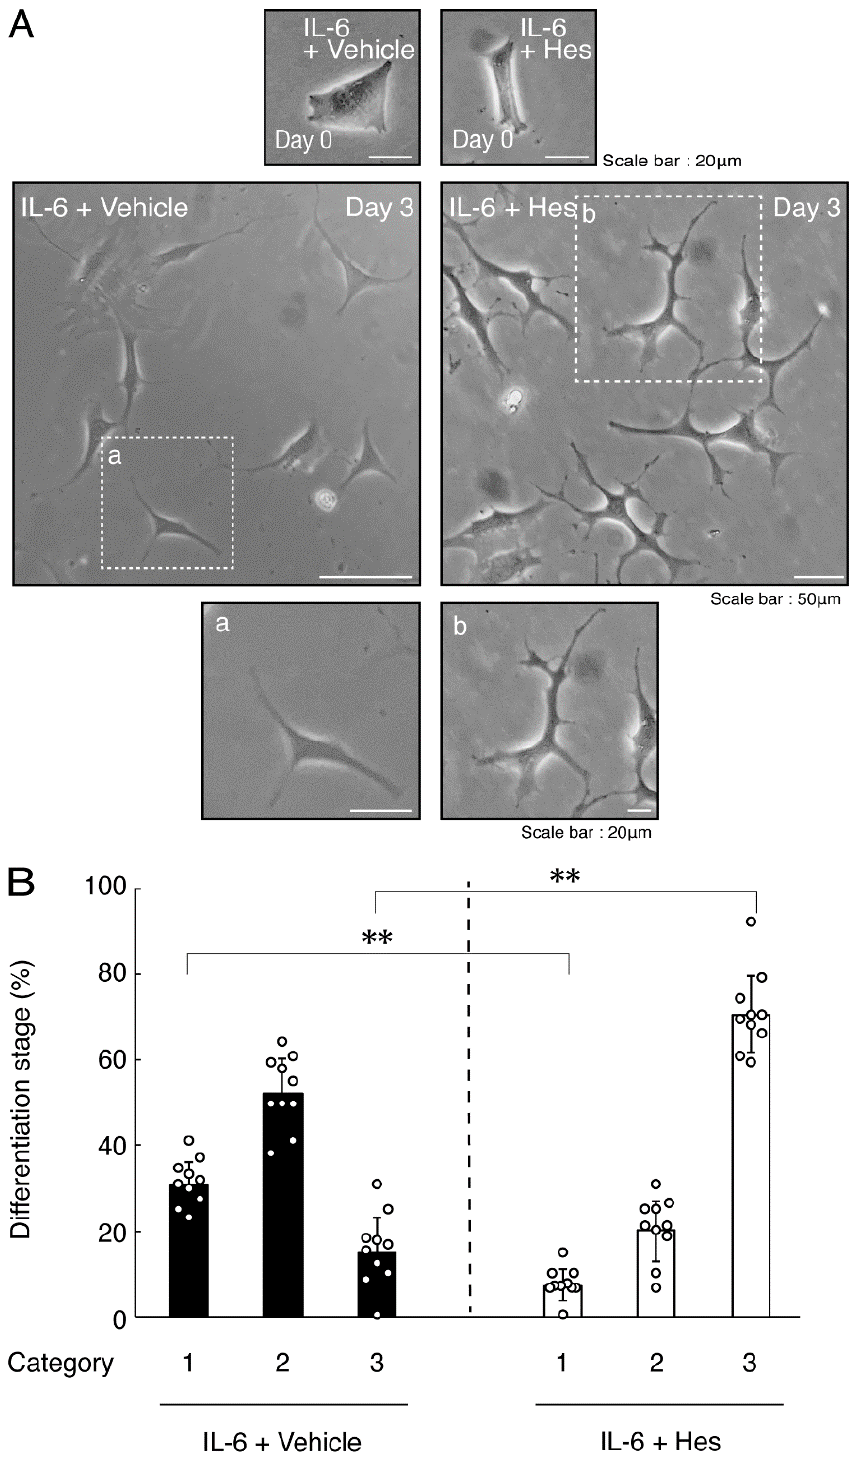
Figure 8. Hesperetin recovers IL-6 inhibition of oligodendroglial cell morphological differentiation. ( A , B ) Differentiation of FBD-102b cells treated with IL-6 was induced in the presence of hesperetin (Hes) or control vehicles. Lower panels a and b are magnified dotted squares a and b of middle panels. Differentiation efficiencies were divided into 3 categories and depicted in graphs (**, p < 0.01; n = 10 [taking one picture each from 10 independent experiments]).